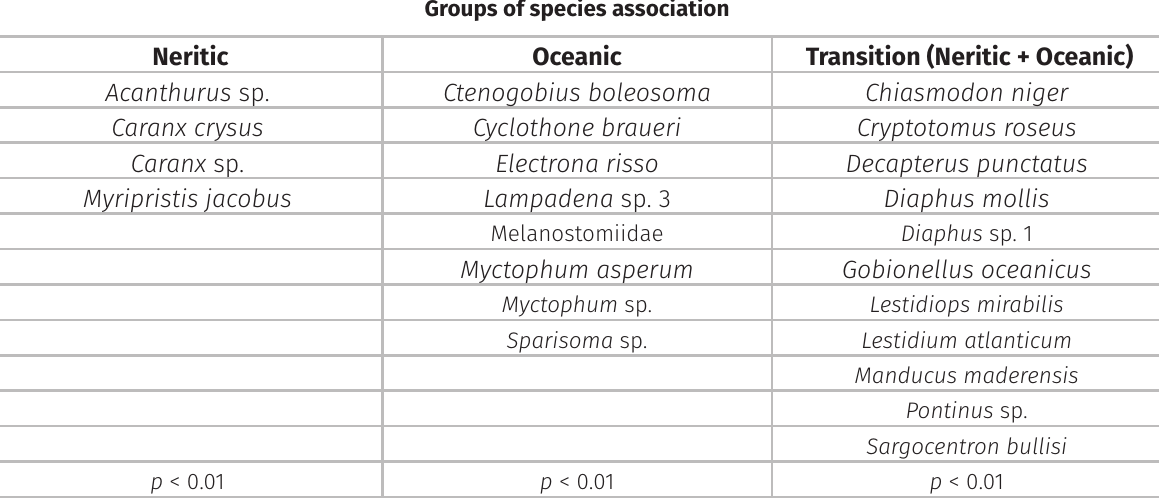
Table II. Groups of species association found with the k means partitioning.